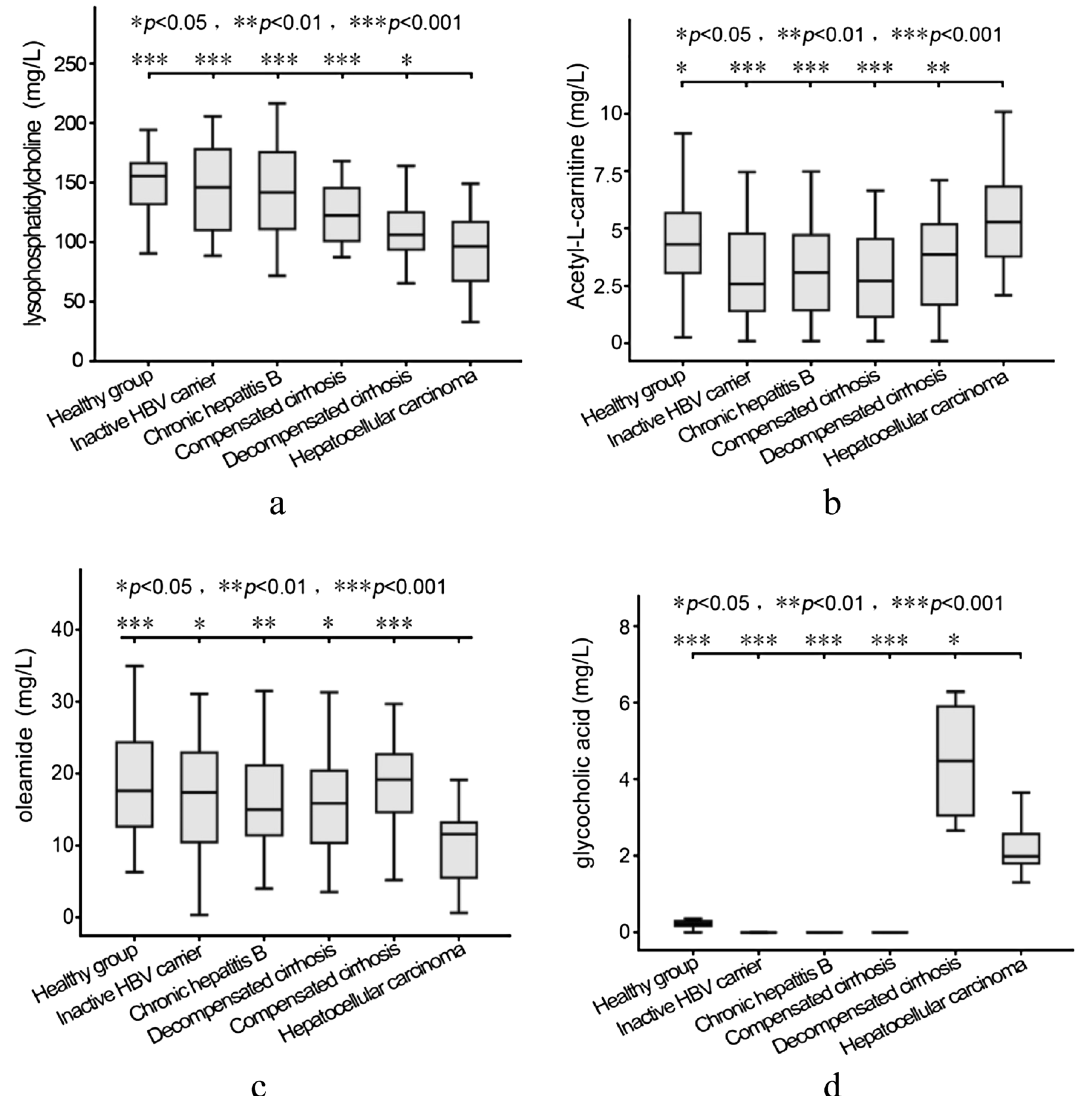
Figure 1. Differences in the four metabolites in the serum of patients with liver diseases at different stages. ( a ) Box plot of lysophosphatidylcholine, ( b ) Box plot of Acetyl-l-carnitine, ( c ) Box plot of Oleamide, ( d ) Box plot of glycocholic acid.